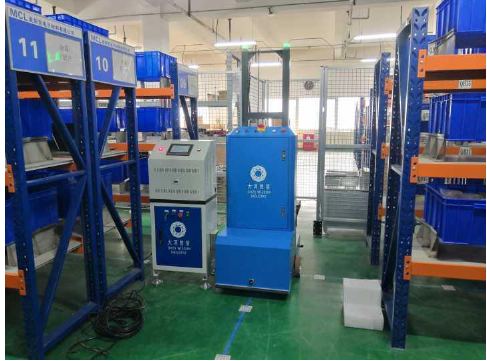
Figure 1. The physical picture of the Automated Guided Vehicle (AGV).